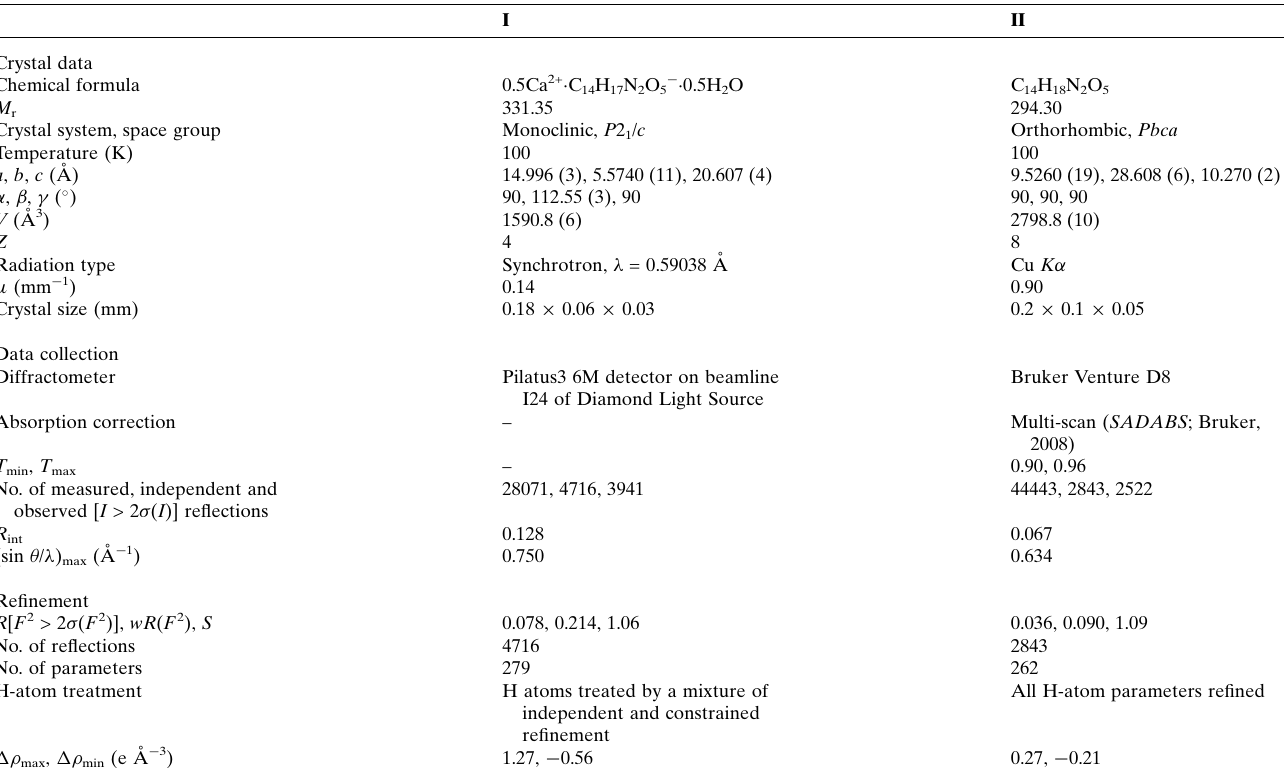
Table 4 Experimental details.